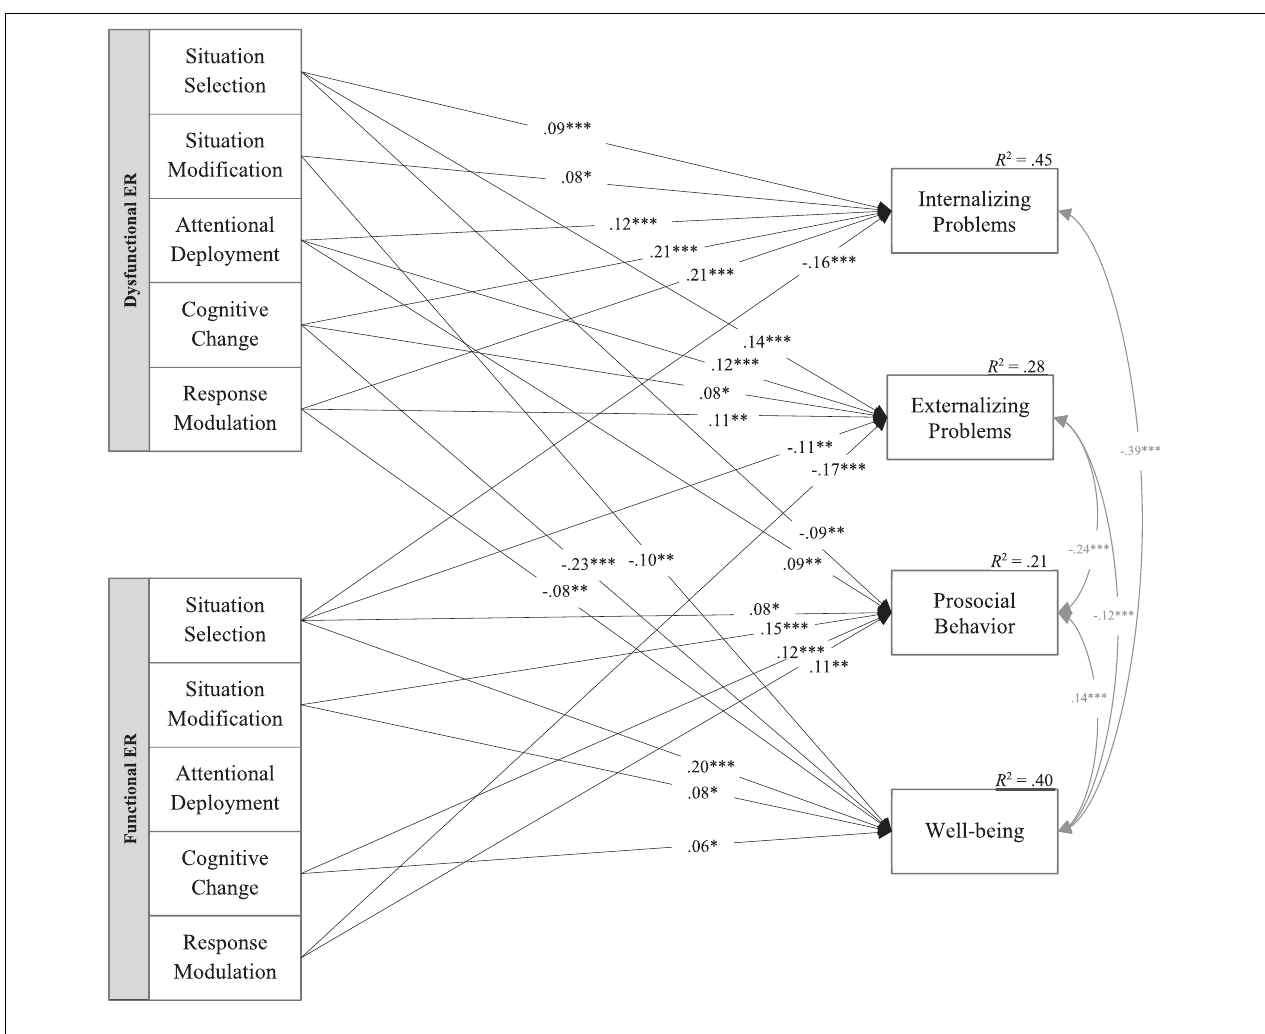
FIGURE 2 | Specific associations of emotion regulation with psychosocial adjustment and well-being (Model 2). This path model shows specific associations of adolescents’ functional and dysfunctional ER, measured by the primary subscales of the POEM-CA, with their psychosocial adjustment (SDQ) and well-being (KIDSCREEN). For reasons of simplification, non-significant paths, associations with age and sex (covariates), and inter-correlations of the independent variables are not displayed. N = 1,727. χ 2 = 9.746, df = 2, CFI = 0.997, RMSEA = 0.047, SRMR = 0.004. ∗ p < 0.05; ∗∗ p < 0.01; ∗∗∗ p <